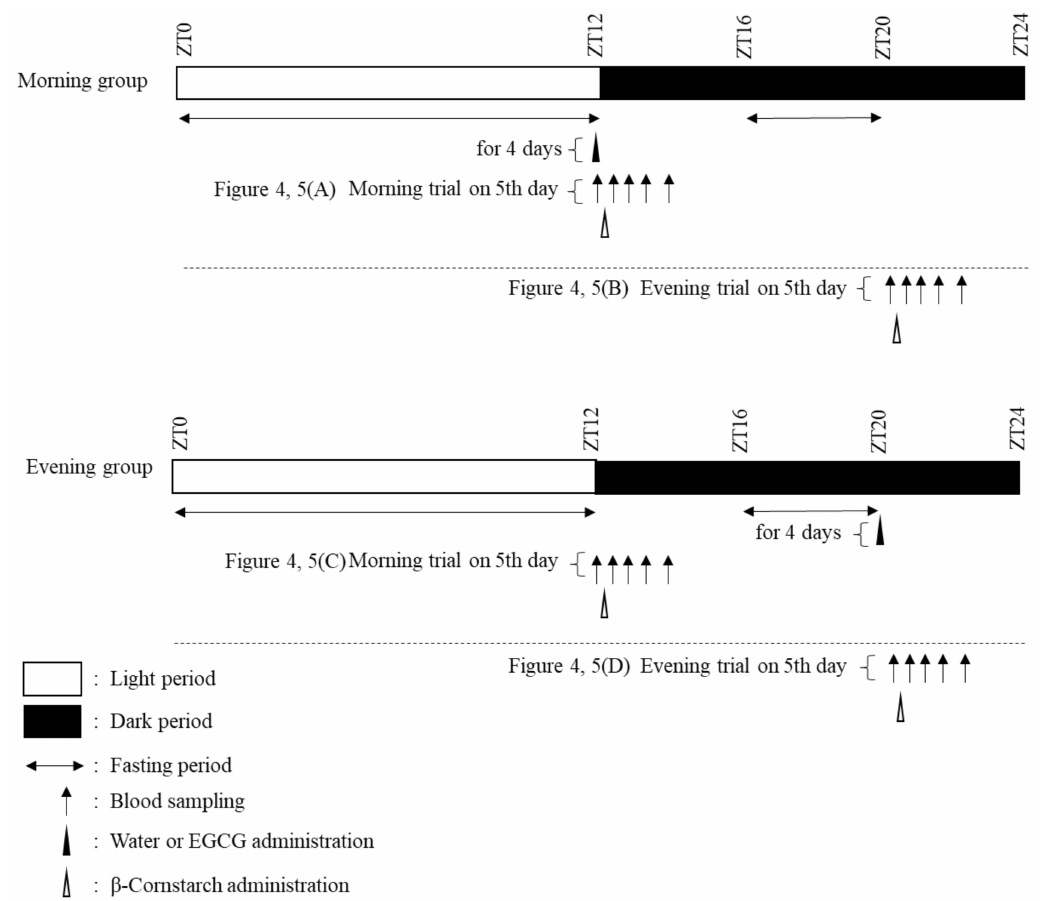
Figure 2. Protocol for consecutive experiments in